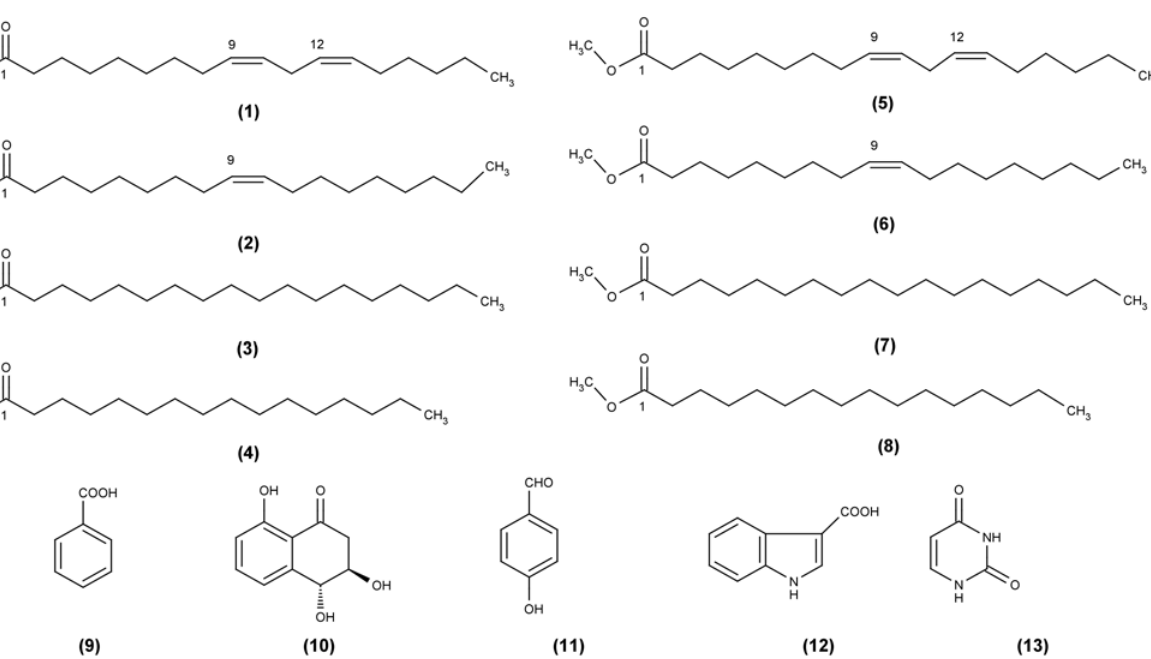
Figure 1. Structures of metabolites isolated from the dichloromethane (DCM) extract of biomass derived from P. ostreatus grown in submerged culture in a batch stirred tank